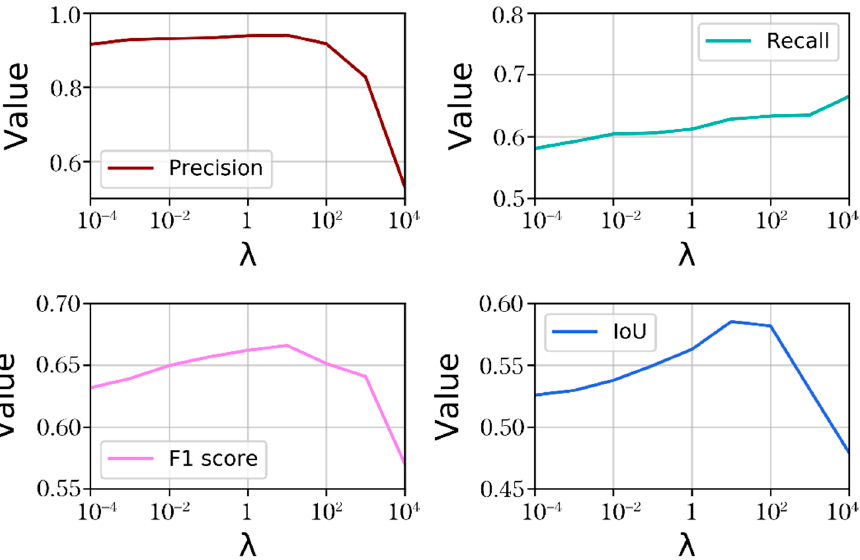
Figure 4. The effects of coefficient λ on the segmentation results. The horizontal axis is the range of λ from 10 − 4 to 10 4 , and the vertical axis reflects the value of each metric. Obviously, optimal segmentation performance of F1 and IoU occurred as the λ reached 10.